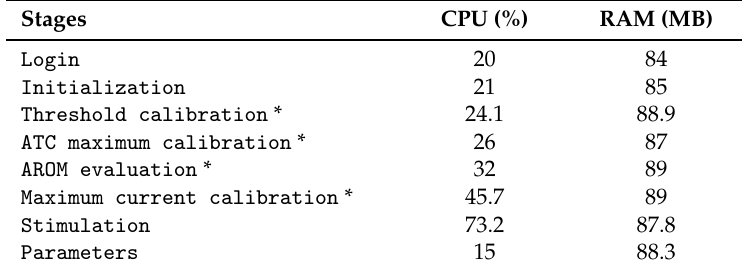
Table 4. CPU and RAM measurements of the application main stages, which have been evaluated testing the Reference Hardware Setup (RHS) with four working channels.